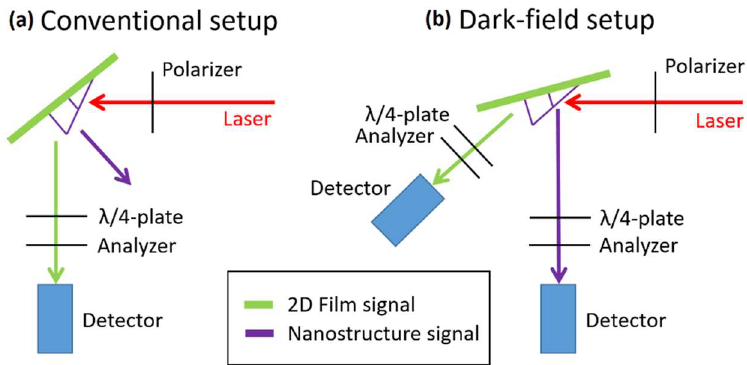
Figure 11. Conventional ( a ) and Dark-Field ( b ) Magneto Optical Kerr Effect (MOKE) magnetometry. A linearly polarized laser (red) is reflected off a substrate, and changes in polarization are analyzed using a combination of a quarter waveplate and an analyzer. In a conventional setup, only the reflection from the substrate is collected (green), while in the dark-field configuration we have recently developed, reflections from both substrate (green) and nanostructure (purple) are analyzed.